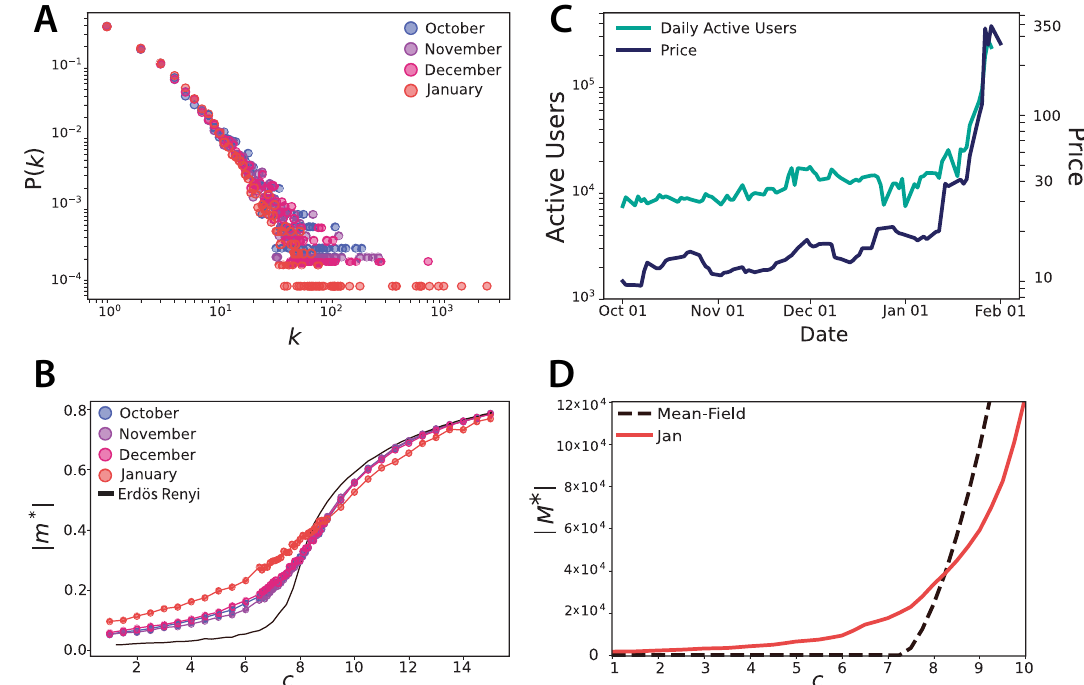
Figure 4. WSB user interaction network and emergence of consensus. ( A ) Degree distributions of the monthly user interaction (’reply-to’) networks, statistically validated using the disparity filter. ( B ) Phase transition of the magnetization, obtained by simulating the model (for (cid:31) = 0.1 ) on the monthly networks, as compared to the transition observed on Erdös-Rényi graphs. ( C ) Number of daily active users (who contribute at least one post/ comment) and daily closing price of GME shares. ( D ) Phase transition of the extensive order parameter of